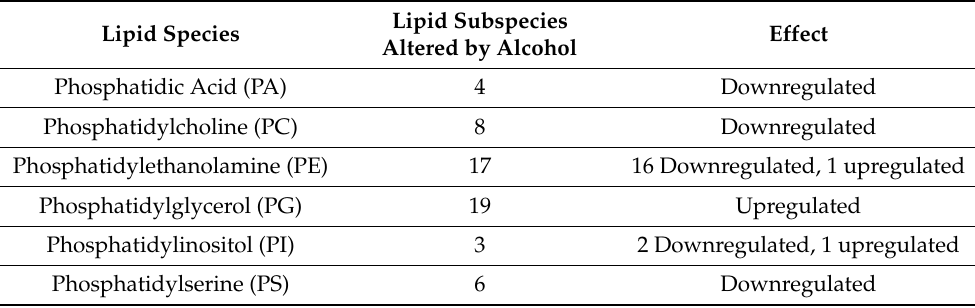
Figure 4. Significantly altered ( p < 0.05) Phosphatidylcholine and Phosphatidic Acid subspecies in the maternal blood following gestational alcohol exposure. ( A ) Targeted analysis of Phosphatidylcholine (PC) and ( B ) Phosphatidic Acid (PA) was performed to identify PC and PA levels in rat maternal blood following alcohol consumption during pregnancy. *, p < 0.05. Table 3. Species of lipids and their corresponding lipid subspecies number, which was significantly altered by alcohol following targeted lipidomic